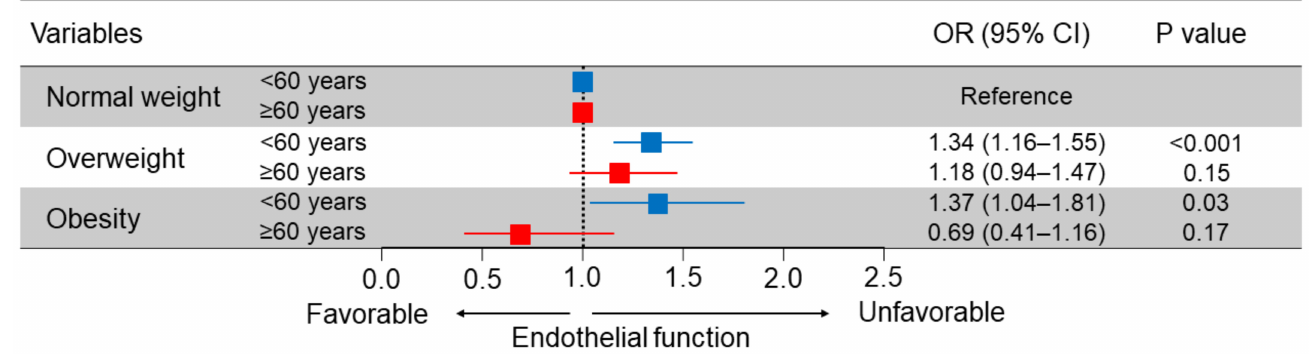
Figure 2. Odds ratios and 95% confidence intervals, adjusted for the presence of hypertension, dyslipidemia, diabetes, and smokers, for endothelial dysfunction according to obesity status. The subjects with a lower quartile of flow-mediated vasodilation (FMD) were defined as subjects having endothelial dysfunction (FMD of less than 4.2% in subjects aged <60 years, FMD of less than 2.1% in subjects aged ≥ 60 years). Reprinted with permission from Ref. [5]. Copyright 2021 Elsevier.